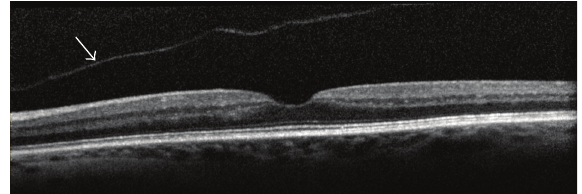
Figure 3: Posterior vitreous detachment